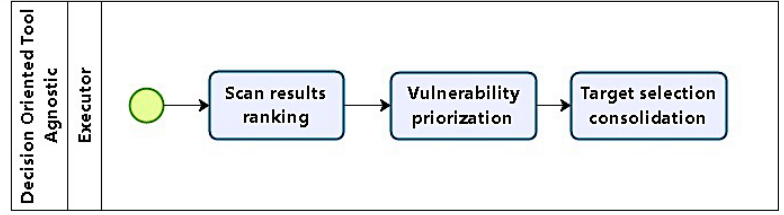
Figure 4. Phase 3: Target selection.